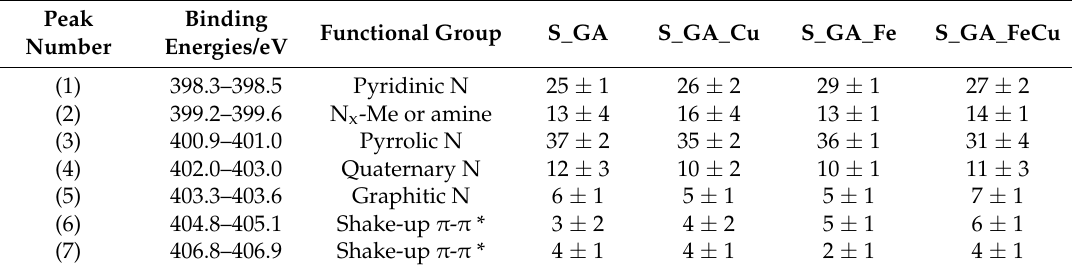
Table 3. Relative Peak Areas (RPA%) of N1s peaks *.